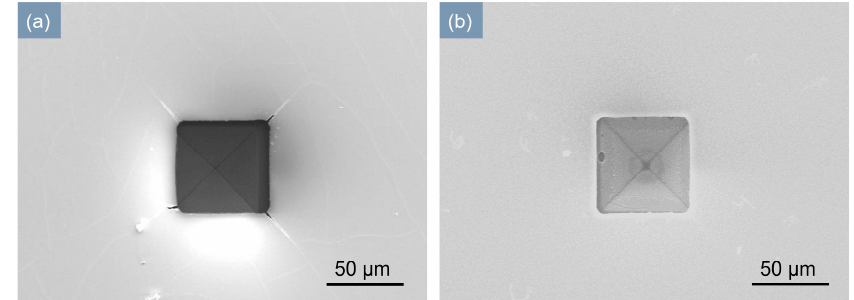
Figure 6. SEM images of inverted pyramid MDBD device. ( a ) After deposition of 2 μ m-thick-SiN x by original recipe of PECVD (Plasma System100); ( b ) After deposition of 2 μ m-thick-SiN x by optimized recipe of PECVD (PD-220, SAMCO).